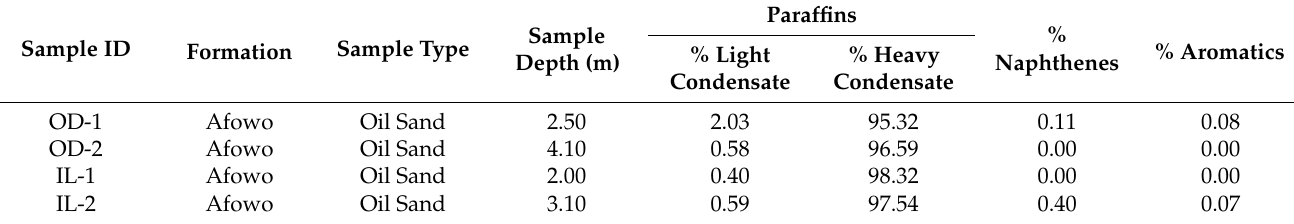
Table 2. TD-GC hydrocarbon composition